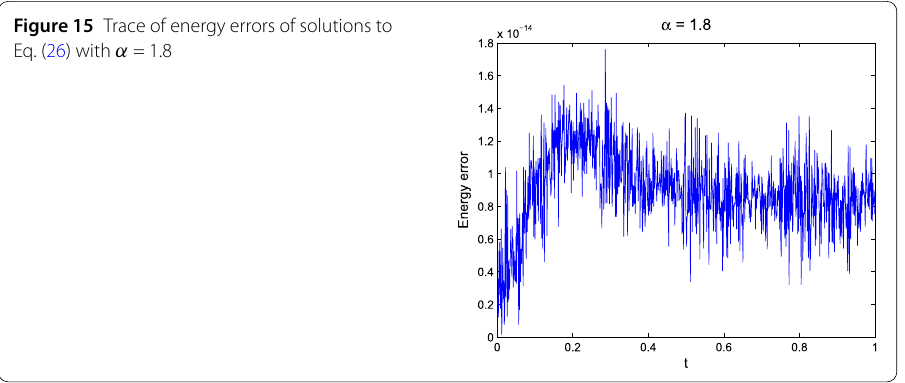
Figure 15 Trace of energy errors of solutions to Eq. (26) with α =